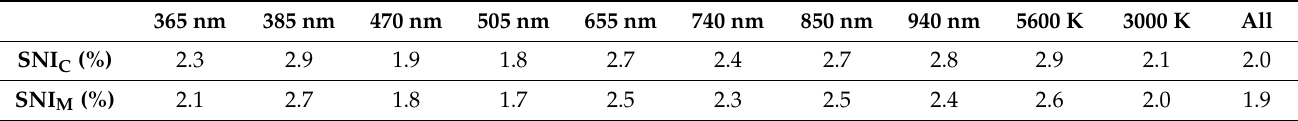
Table 4. Calculated and measured SNI for each of the 10 selected LED